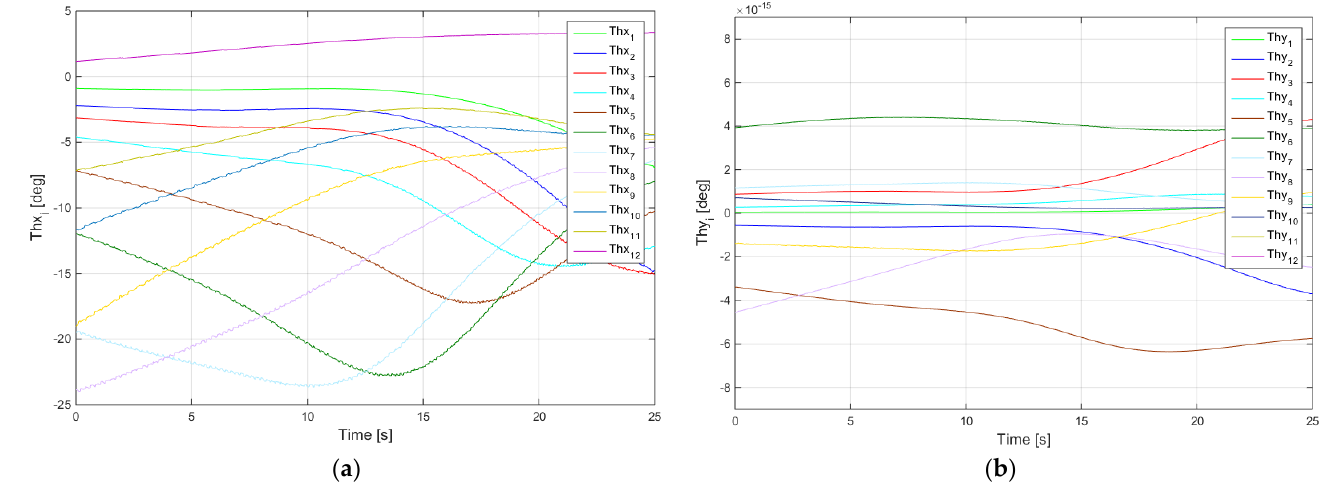
Figure 10. Variation of the joint angles ( a ) angle 𝜃 𝑥𝑖 ( b ) angle 𝜃 𝑦𝑖 . The variation of the imposed position for P 12 (reference value) and the position resulting at the robot’s 12th universal joint (the associated point P 12 on the robot) are presented in Figure 11a. The obtained absolute errors between the two parameters along the Ox , Oy and Oz axis are displayed in Figure 11b.